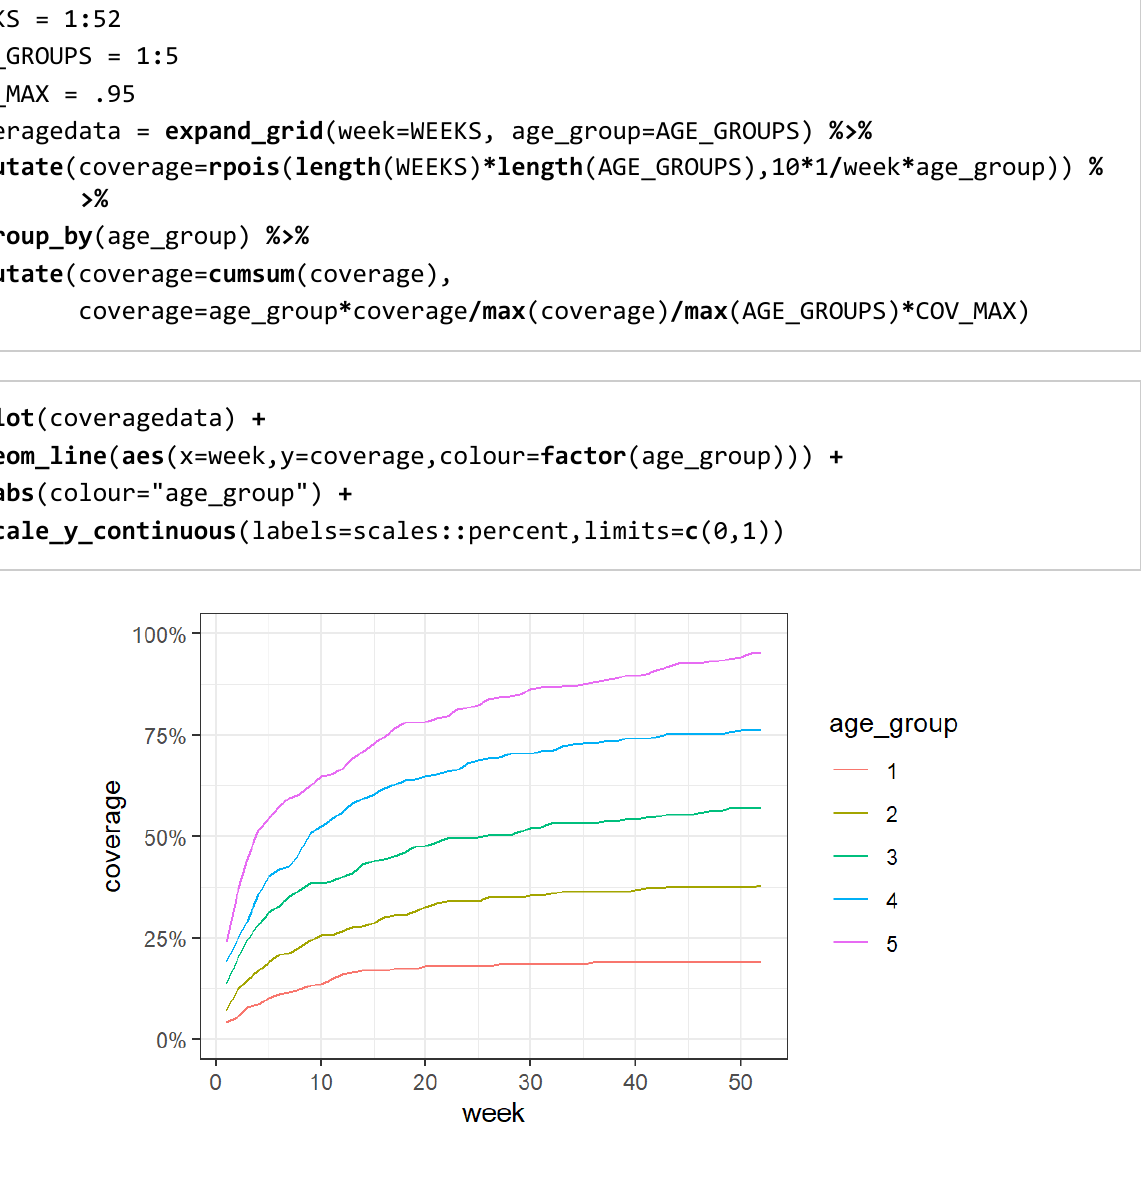
Figure S6. Simulated vaccination coverage in time by age